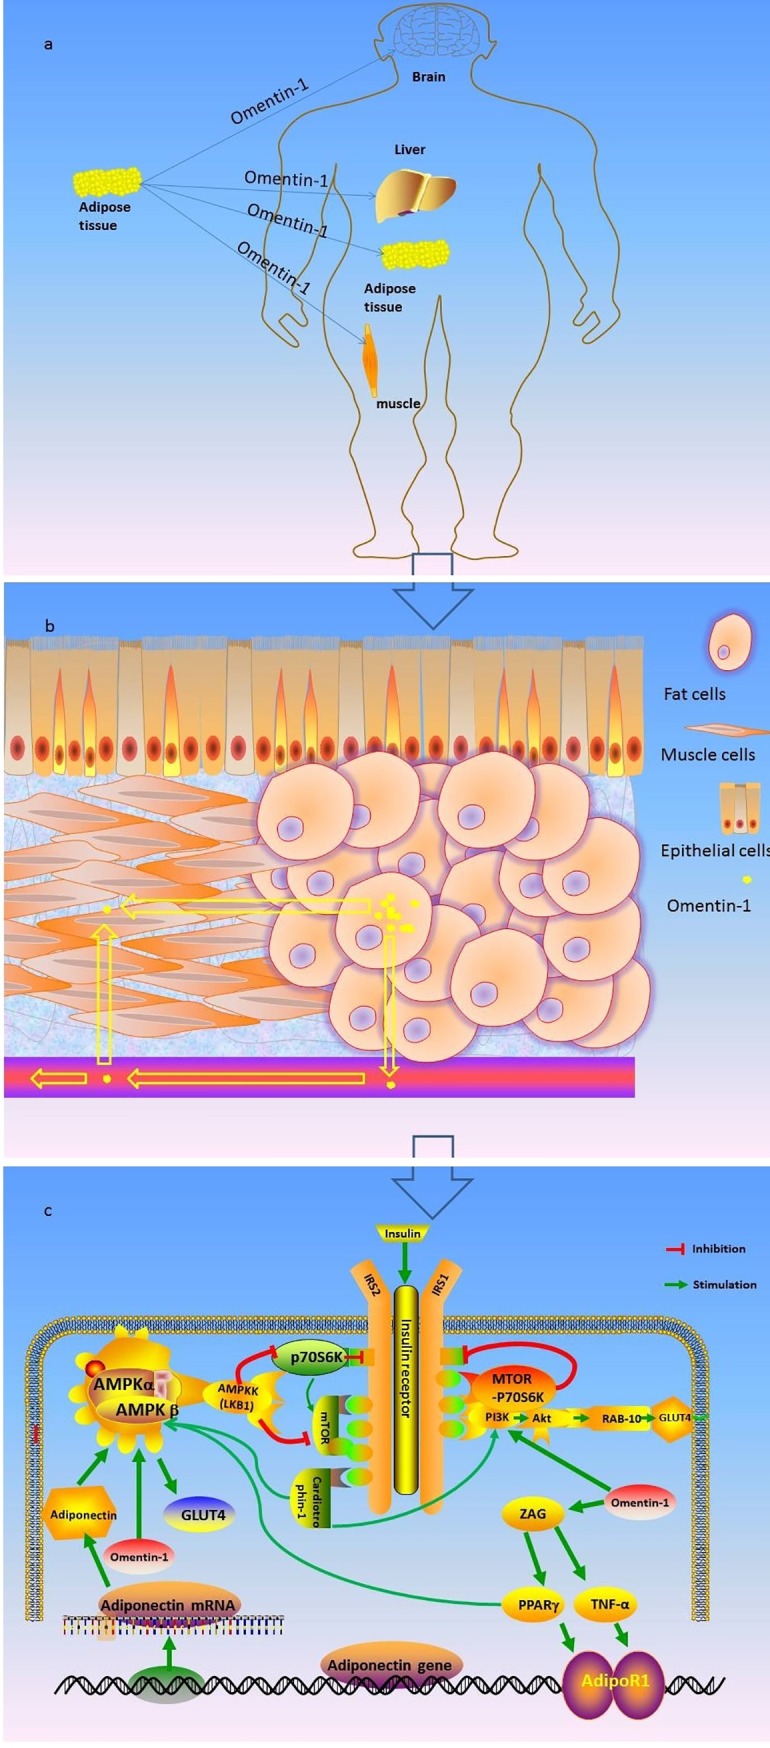
Summarizes the hypothesis mechanism process of omentin-1 on insulin signaling cascade.Fig 3 Schematic representation of the effects of omentin-1 on insulin signaling cascade that explain positive effects of these adipokines on glycemic control. Akt: protein kinase b; TNF-α: Tumor Necrosis Factor; AMPK: AMP activated protein-kinase; ZAG: Zinc-α2-glycoprotein; AS160: Akt substrate of 160 kDa; GLUT: glucose transporter; IRS: insulin receptor substrate; mTOR: mammalian target of rapamicin; PPAR-γ: peroxisome proliferator-activated receptor; AdipoR1: Adipo receptor1; PI3K: phosphatidylinositol 3-kinase; RAB-10: Ras-related protein RAB-10. Fig 1 is drawn by the KA, without any copyright disputes.